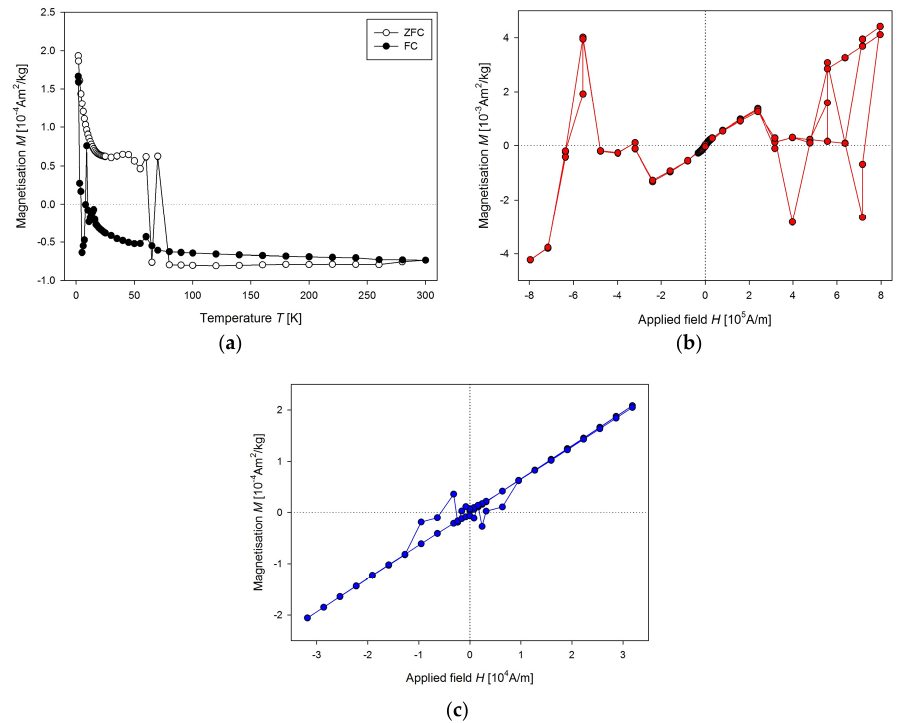
Figure 4. ( a ) Temperature dependence of the mass magnetisation of the same sample as in Figure 3, ( b ) M ( H ) dependence of the WKY rat heart at 300 K, ( c ) M ( H ) dependence of WKY rat liver at 300 K.